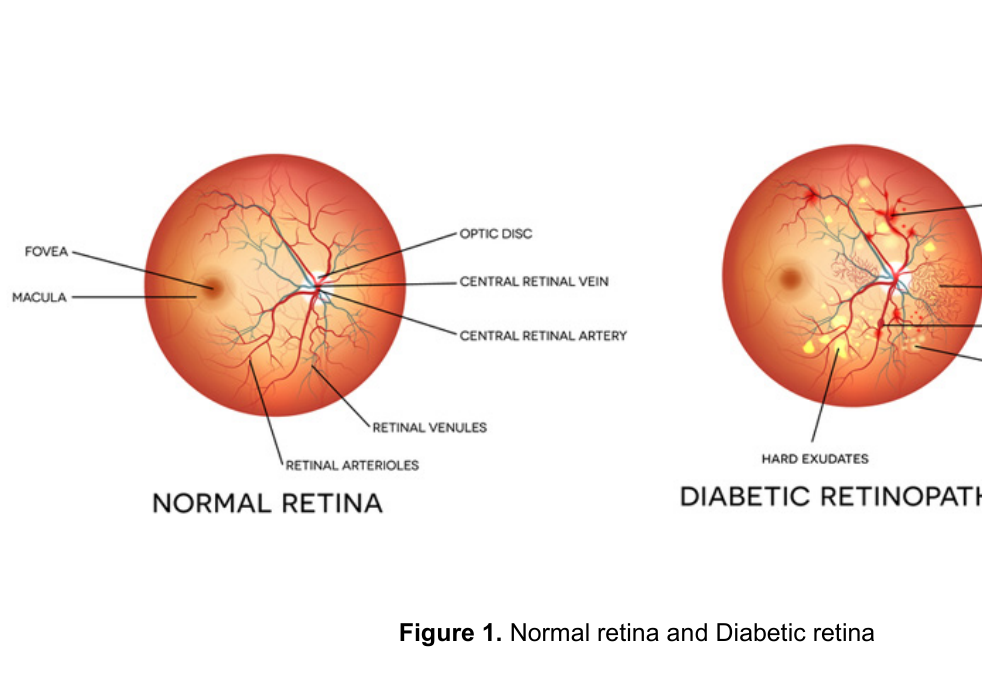
Figure 1. Normal retina and Diabetic retina